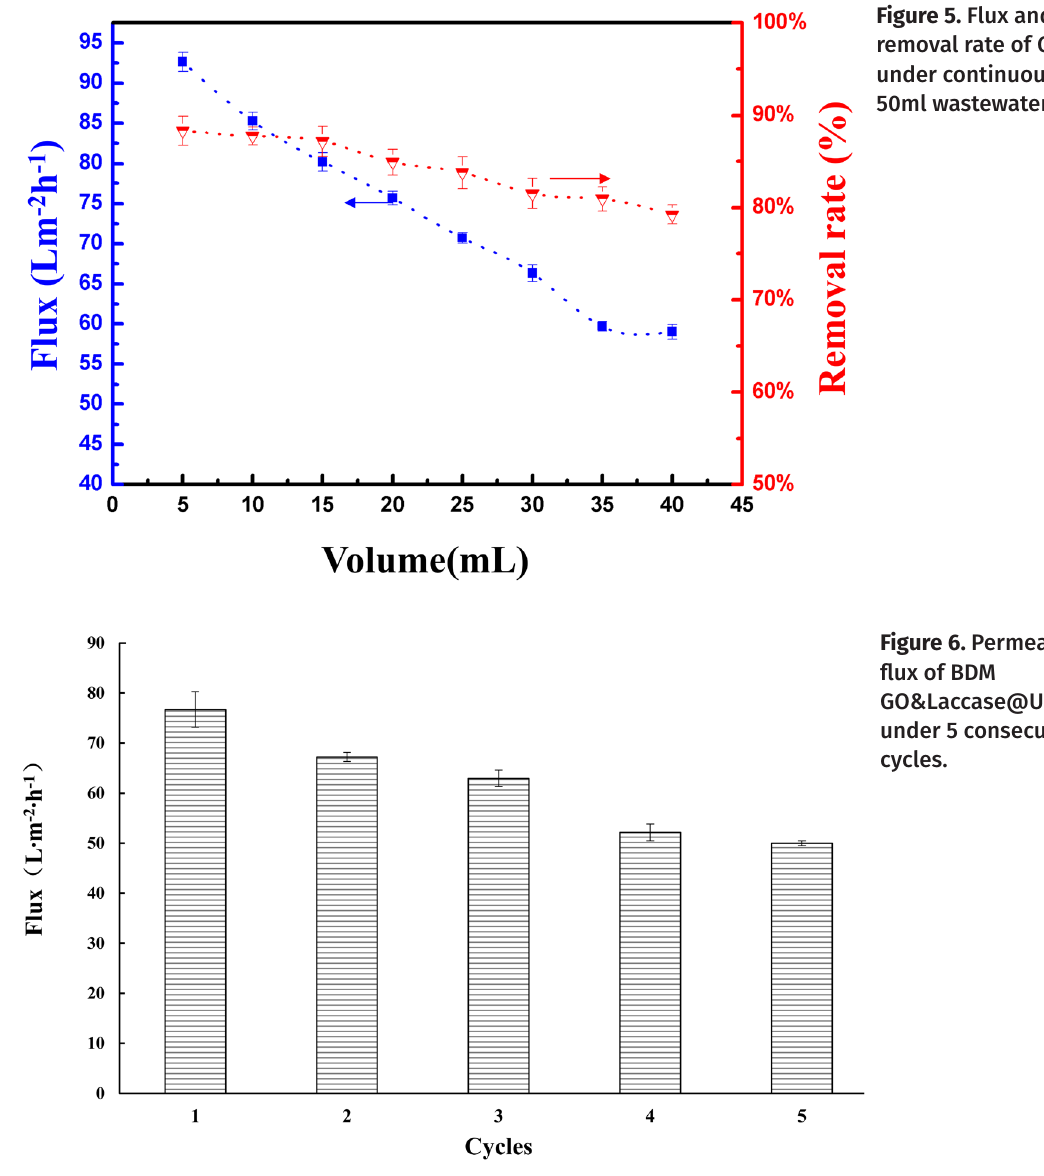
Figure 5. Flux and colority removal rate of GO-BDM@UF under continuous filtration of 50ml wastewater.